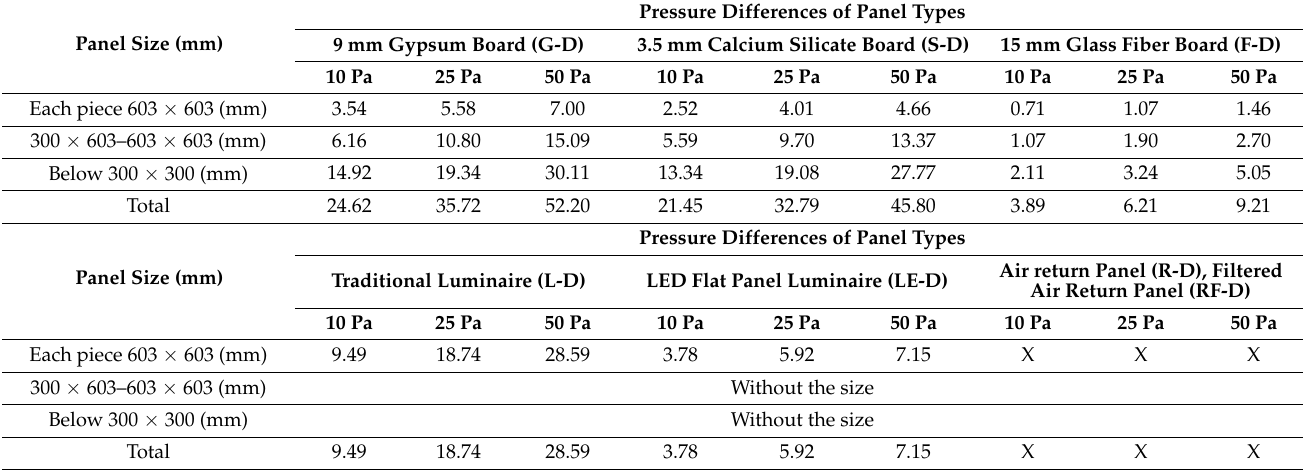
Table 5. Leakage volume per unit for various test specimen sizes from bottom to top (U) (m 3 /(h.m.)).